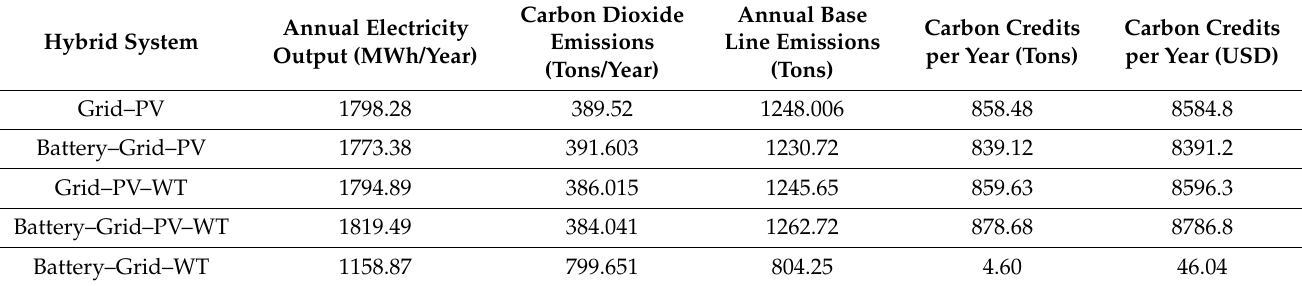
Table 7. Carbon credit analysis.